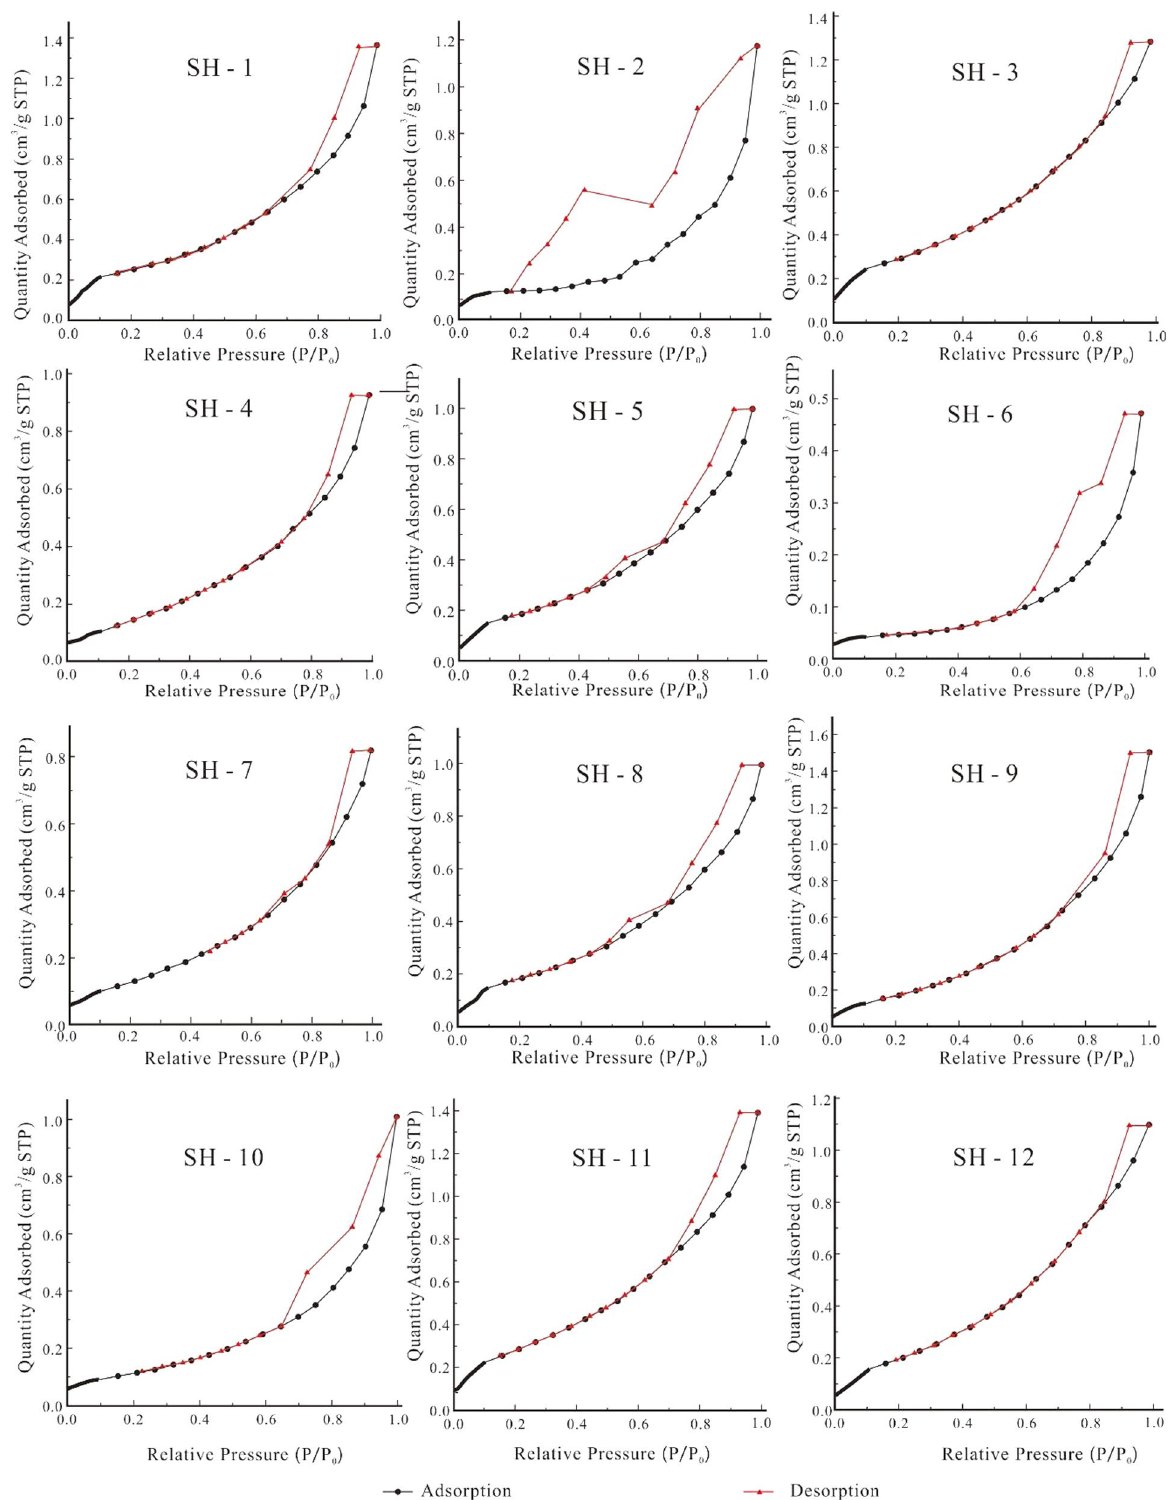
Fig. 7 Low-temperature N 2 adsorption/desorption isotherms of the coal